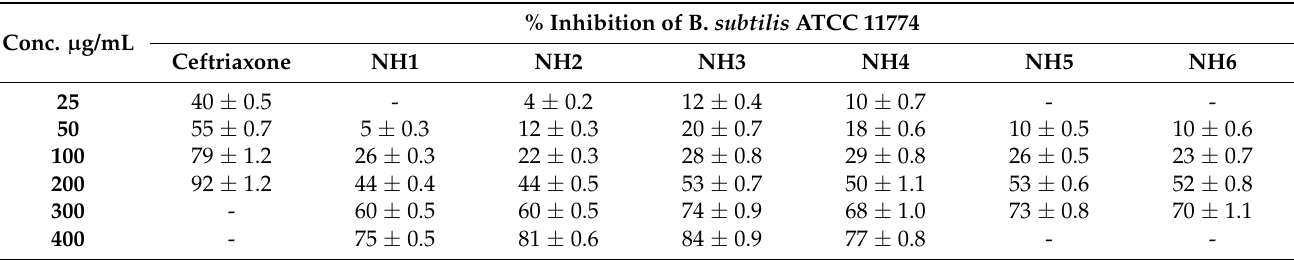
Table 4. Minimum inhibitory concentration of synthesized compounds against Bacillus subtilis